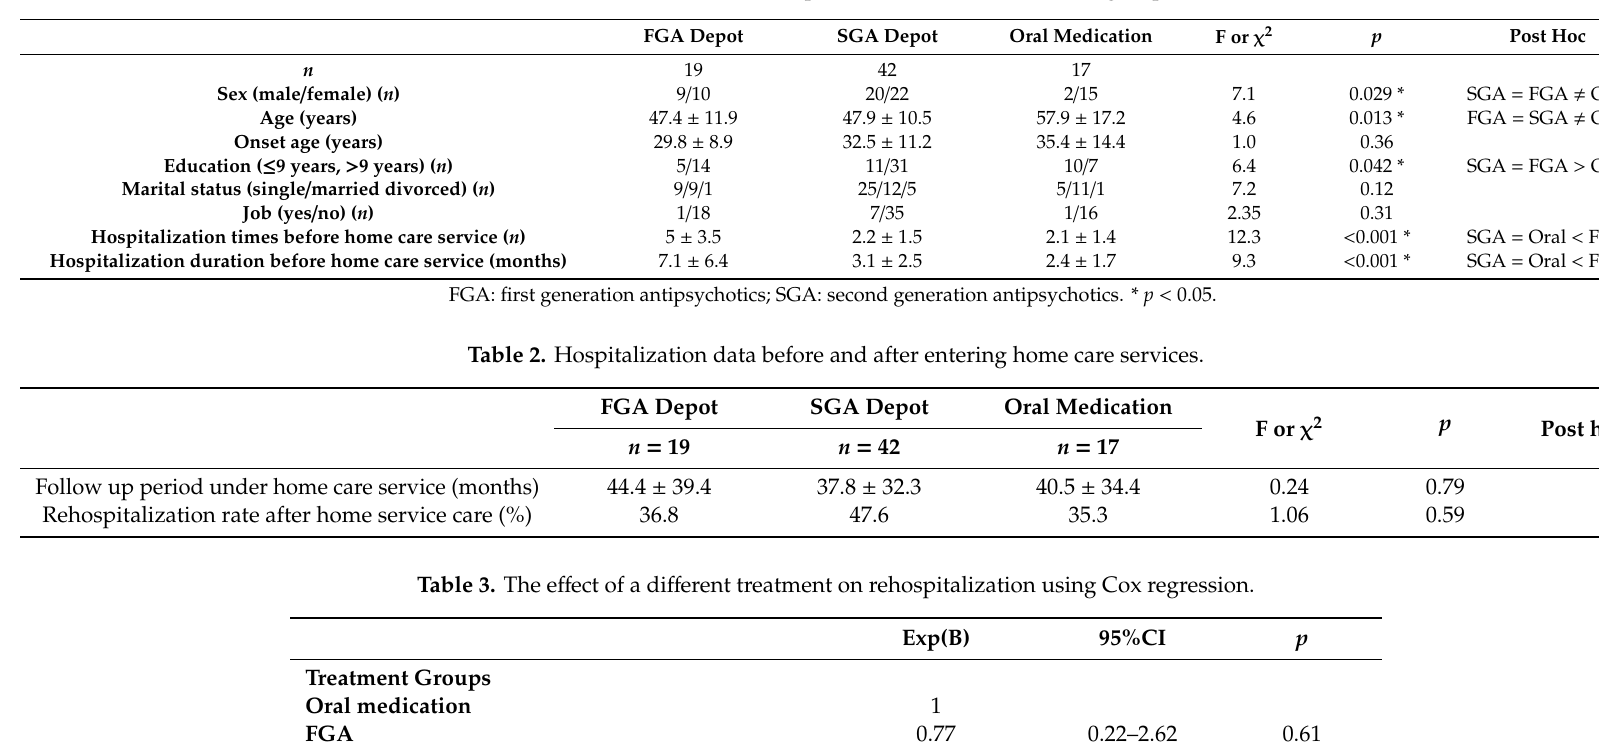
Table 1. Basic characteristics of patients in di ff erent treatment groups.